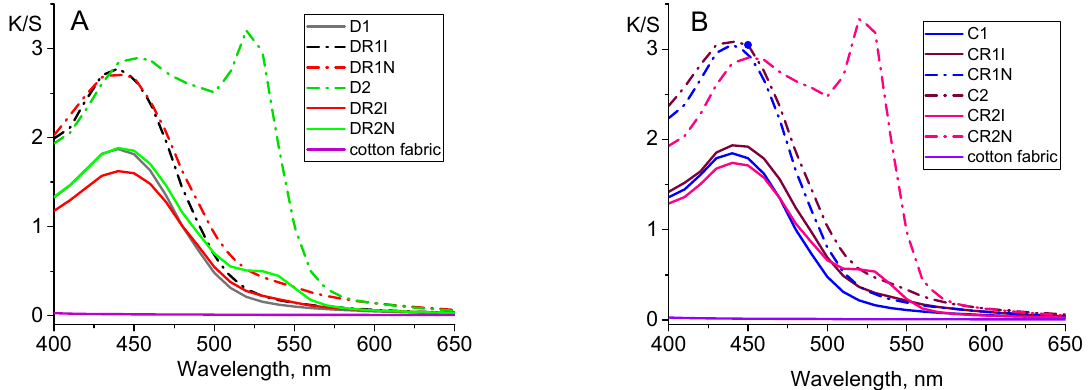
Figure 6. K/S values of fabric samples, dyed with dendrimer D ( A ) and [Cu 8 (D)(NO 3 ) 16 ] ( B ). The spectra of the cotton fabrics dyed with the dendrimer complex are approximately the same with small but intrinsic differences. The absorption maximum for the samples dyed with the dendrimer complex is also at 440 nm (C1 and C2). The band for eosin Y in the spectra of CR1N and CR2N appears at the same wavelength as in the spectra of DR1N and DR1N. However, after illumination, the intensity of absorption at 440 nm increases for both samples (CR1I and CR2I), which can be explained by the formation of copper nanoparticles. The data for the color space coordinates (light–dark (L*), red − green (a*) and yellow − blue (b*) values) of the samples were compared and are shown in Table 2. The a* and b* values of fabrics dyed with dendrimer D and its copper complex are very close to one another. L* is lower for fabrics C1 and C2 than for D1 and D2, respectively. Dyeing with a higher dendrimer concentration or a dendrimer complex gives the fabrics darker, redder, and yellower colors. After treatment with the reducing system (eosin Y and MDEA) and illumination, the colors of all samples are less yellow, and b* decreases while L* and a* values increase. More significant changes are observed between samples DR2I and CR2I than between DR1I and CR1I. Table 2. CIELAB values of pristine cotton fabric and other fabrics under study.